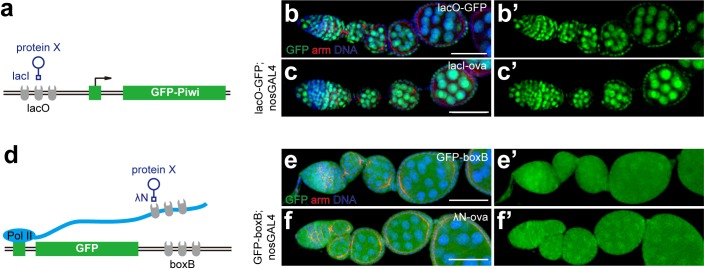
Tethering Ova to DNA or RNA is unable to induce co-transcriptional gene silencing.(a), A cartoon to describe the DNA tethering assay using the lacI and lacO binary system. (b, b’, c, c’) Confocal images of GFP expression in ovarioles of indicated genotypes. Green, anti-GFP staining. Red, anti-Armadillo. (d), A cartoon to describe the RNA tethering assay using λN and boxB binary system. (e, e’, f, f’) Confocal images of GFP expression in ovarioles of indicated genotypes. Scale bars, 50 μm.